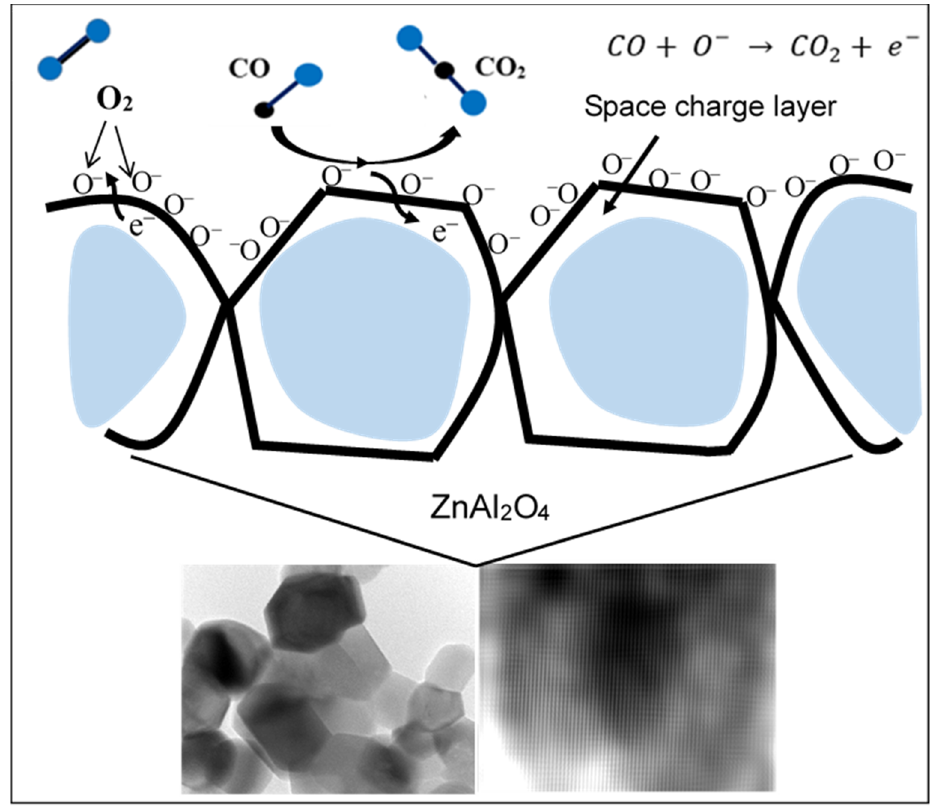
Figure 14. Simple structural model of the reaction mechanism upon exposure to gas.